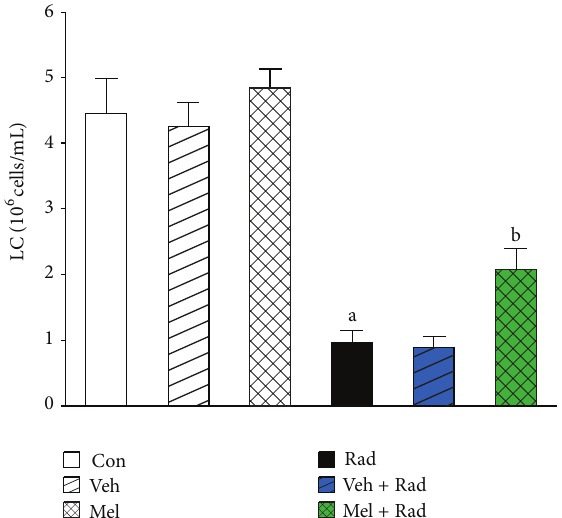
Figure 9: The effect of melatonin on LC in rats subjected to whole body gamma irradiation. Data represent mean ± standard error on the mean (SEM) for 5 animals per group. Con: Control group, Veh: Vehicle only group, Mel: Melatonin only group, Rad: Radiation only group, Veh + Rad: Treated with vehicle and exposed to 10Gy radiation, and Mel + Rad: Treated with 100mg/kg melatonin before exposure to 10Gy radiation. a 𝑃 < 0.001 when compared to Control group. b 𝑃 < 0.001 when compared to the Radiation only group.